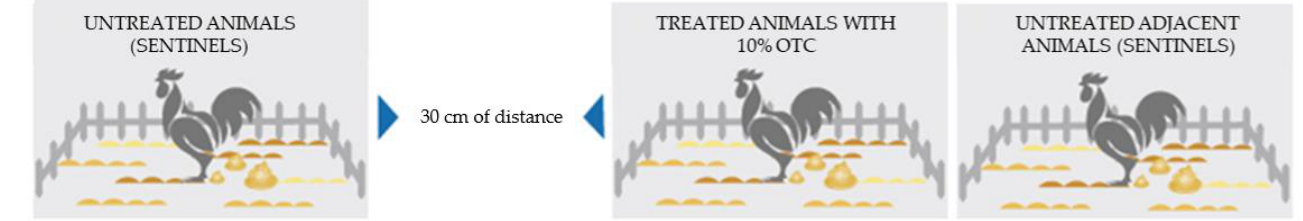
Figure 1. Schematic diagram of the placement of experimental groups; on the left group C, sentinels 30 cm from treated birds; in the center group A, birds treated with 80 mg kg −1 of OTC; and on the right group B, sentinels in adjacent pens.